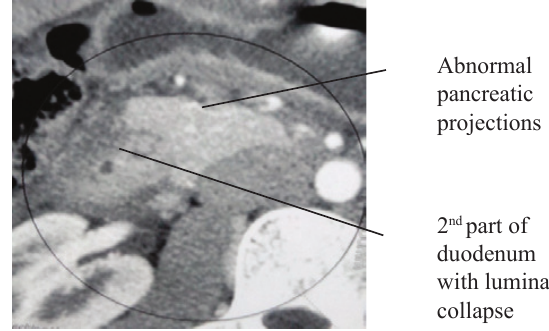
Figure 1: CECT of abdomen revealing incomplete annular